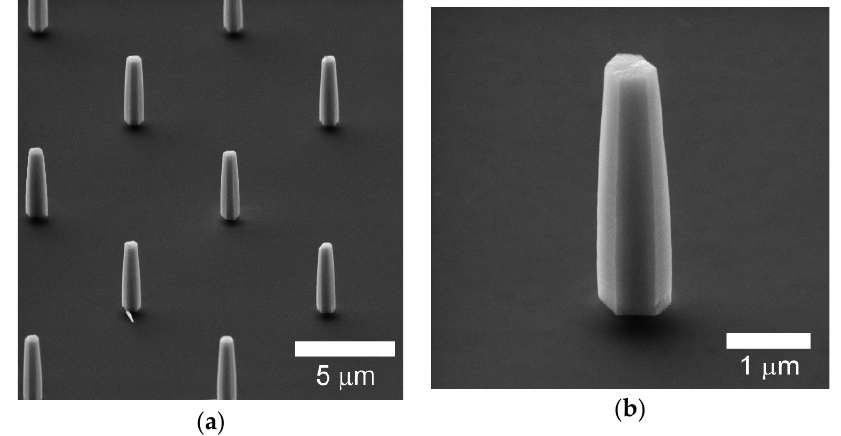
Figure 3. ( a ) SEM image of the array of ZnO nanorods and ( b ) of a single ZnO nanorod on the GaN substrate patterned by FIB.